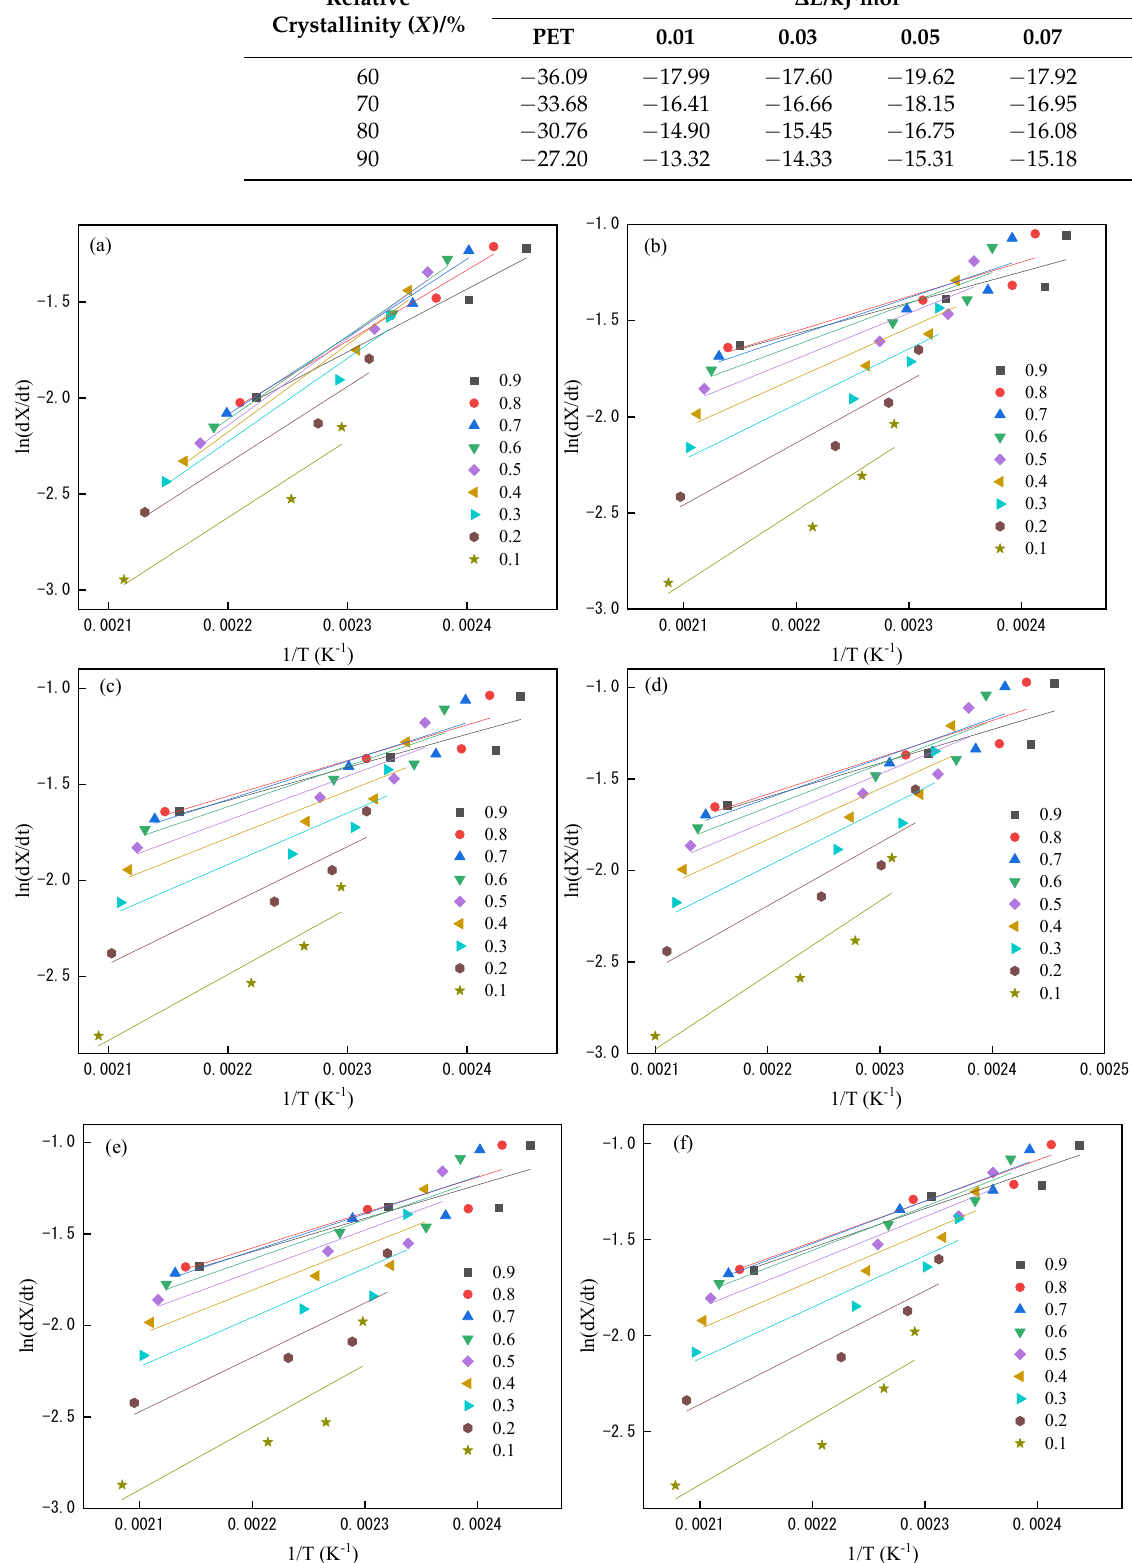
Figure 8. The fitting curve of PET by Friedman method. ( a ) PET; ( b ) PSLDH 0.01 wt%; ( c ) PSLDH 0.03 wt%; ( d ) PSLDH 0.05 wt%; ( e ) PSLDH 0.07 wt%; ( f ) PSLDH 0.1 Table 6. Non-isothermal crystallization activation energy of PET by Friedman method.